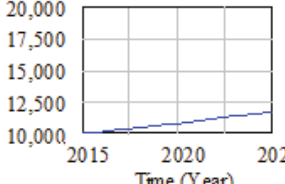
Fig. 18. Electricity consumption by households.